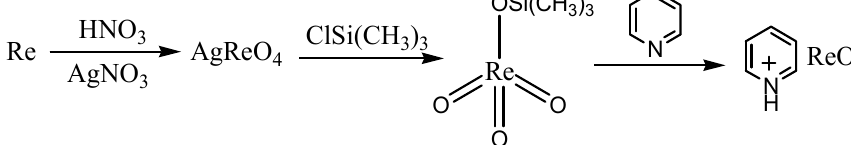
Figure 4. Synthesis of pyridinium perrhenate [50].